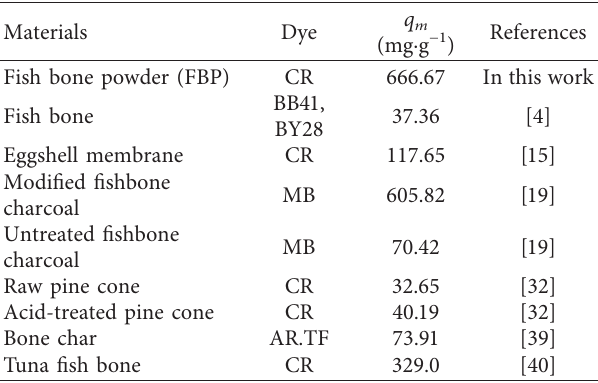
Table 3: Comparison of sorption capacities of low-cost adsorbents for various dyes.